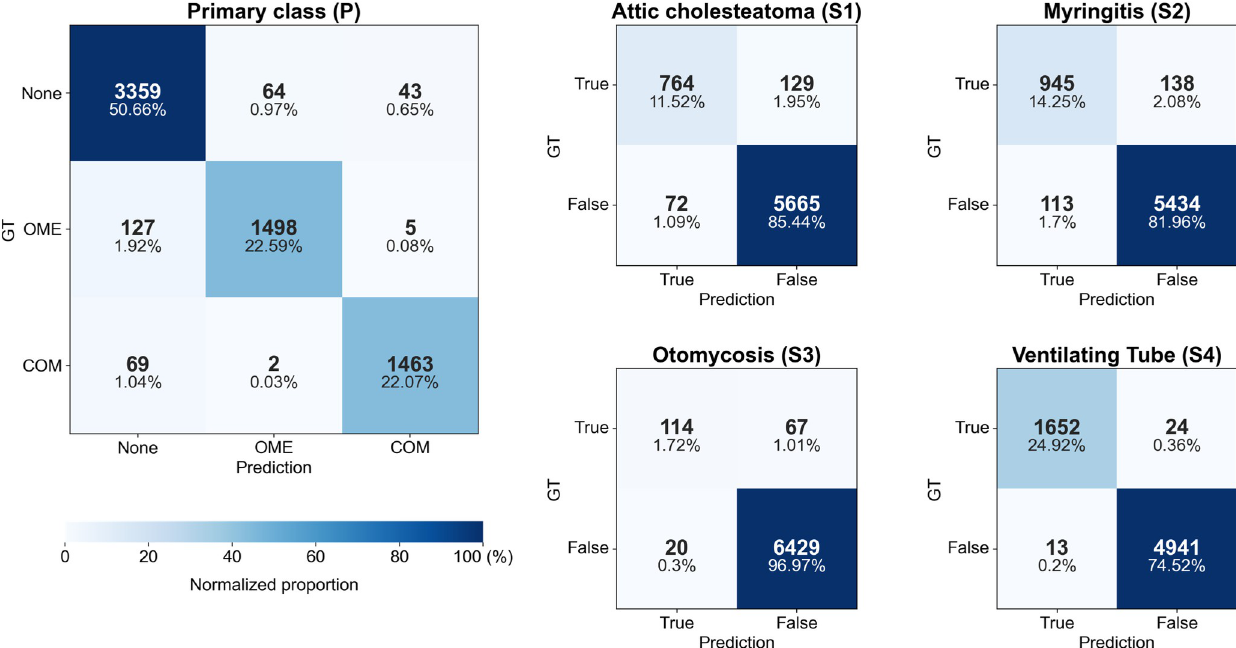
Fig 3. Confusion matrix of combined model in 5-fold cross validation for the prediction of primary and secondary classes. GT, ground truth; OME, otitis media with effusion; COM, chronic otitis